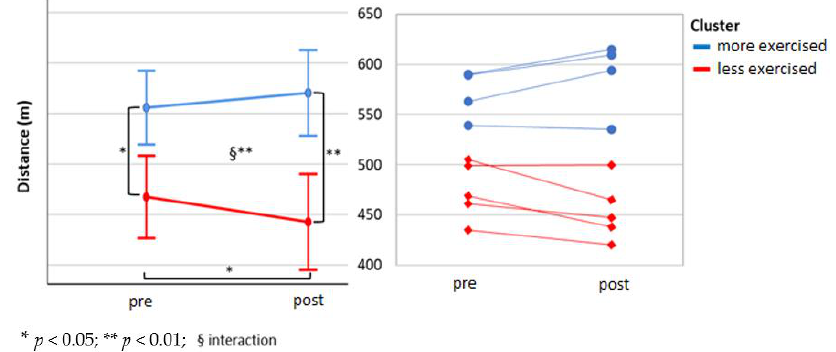
Figure 8. The 6-MWT walking program adherence clusters. Two clusters were yielded from the κ-means clustering method using the walking program adherence as input for recursive feature elimination (based on PCS-12). Cluster 1, higher physical component, in blue; and cluster 2, lower physical component, in red.